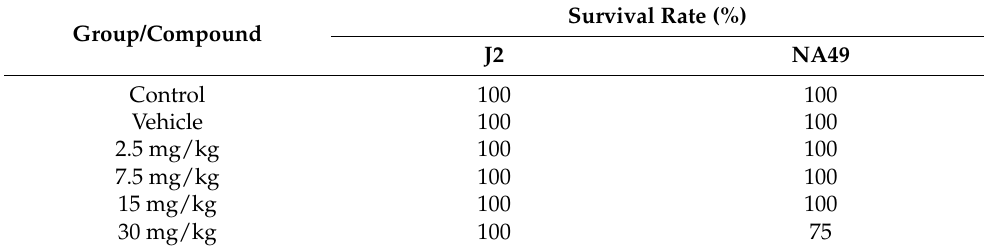
Table 5. Survival rate of ICR mice after a single IV administration of J2 and NA49 ( n =